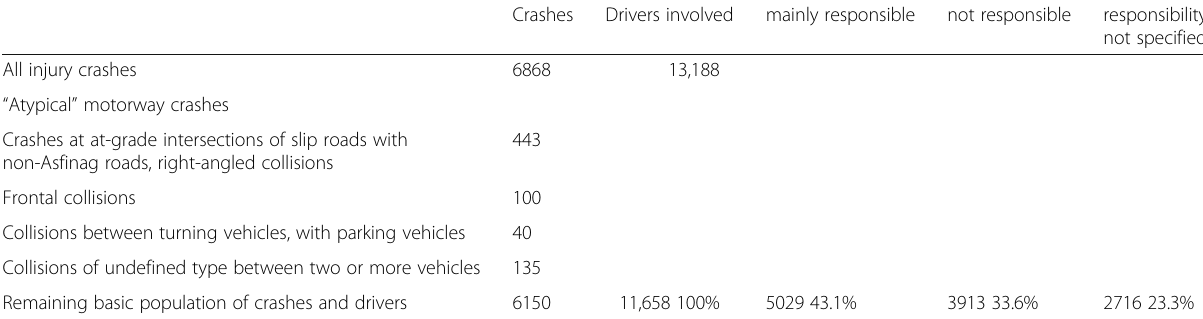
Table 1 Injury motorway crashes 2012 – 2014 on Asfinag roads